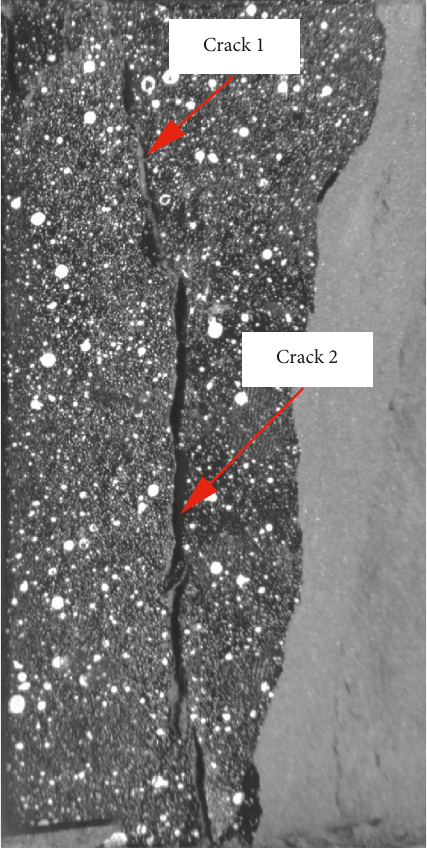
Figure 5: Failure pattern of